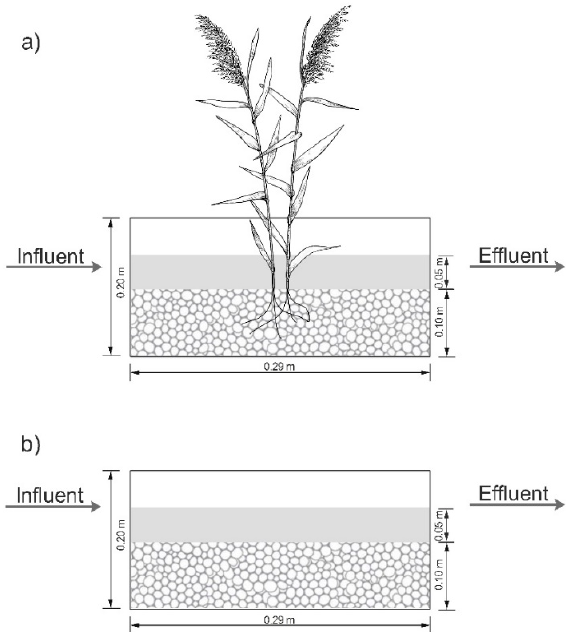
Figure 1. Experimental setup of the lab-scale constructed wetland (CW) units: ( a ) Planted and ( b ) unplanted.